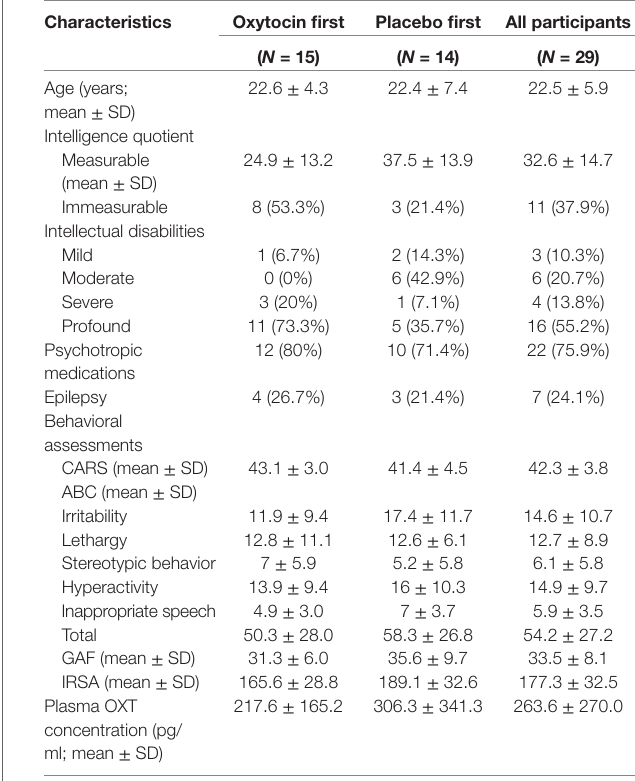
TaBle 1 | Participant characteristics by treatment arm.